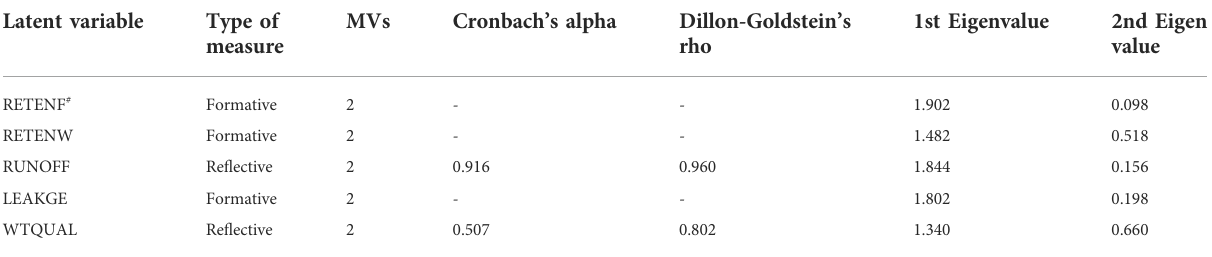
TABLE 3 Unidimensionality measures of the reduced-variable PLS path model. The model had a goodness-of- fi t of 0.697.